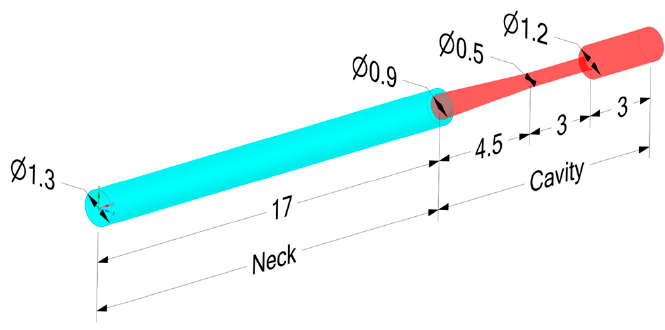
Figure 7. The measuring system as the Helmholtz resonator.